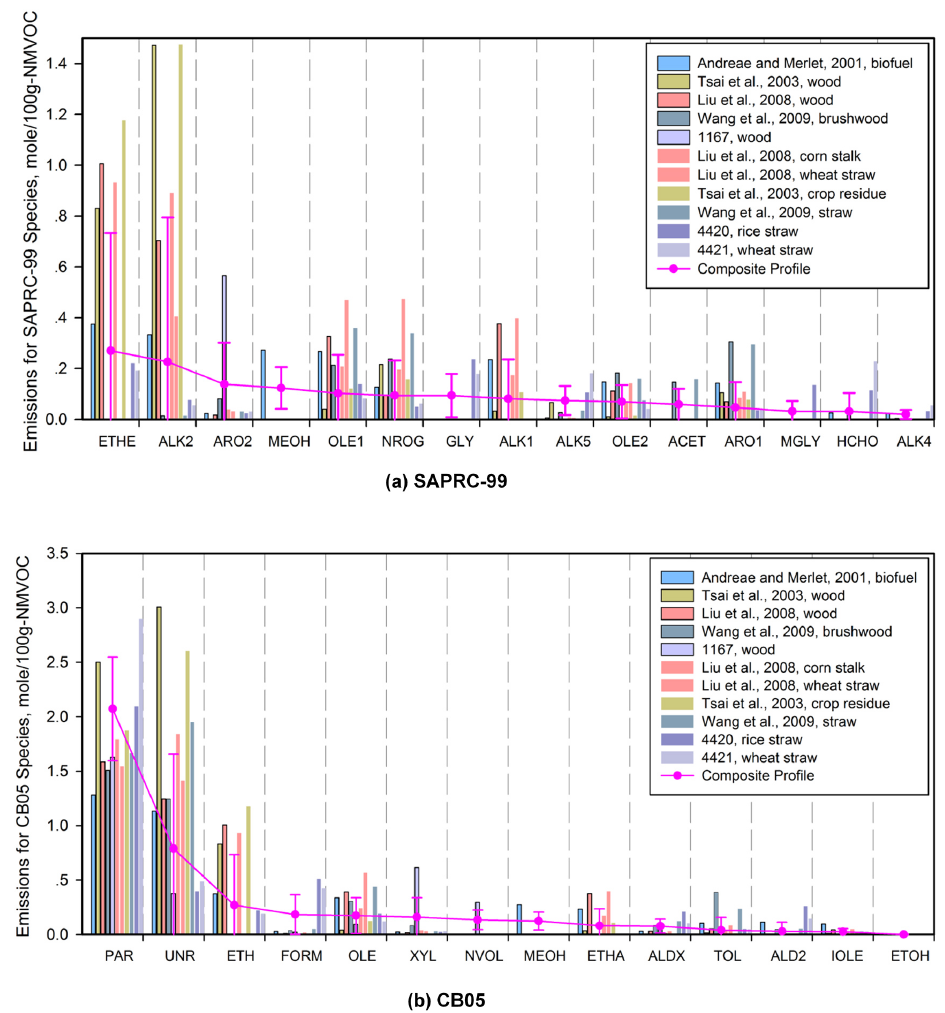
Figure 15. Sensitivity of model-ready emissions to profile selection for the residential biofuel